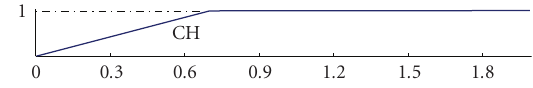
Figure 10: Membership function for S a (CH: considerably high). Figure 8: Membership functions for θ d (S: small, M: medium, B: big). PO11: is the crisp probability output of FLPE11 , for deciding that a ball is between two Figure 9: Membership functions for D (N: near, M: medium, F: far). Table 5: Fuzzy associative memory matrix for a part of FLPE4. D